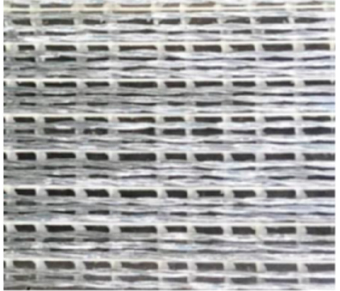
Figure 2. Steel fabric.